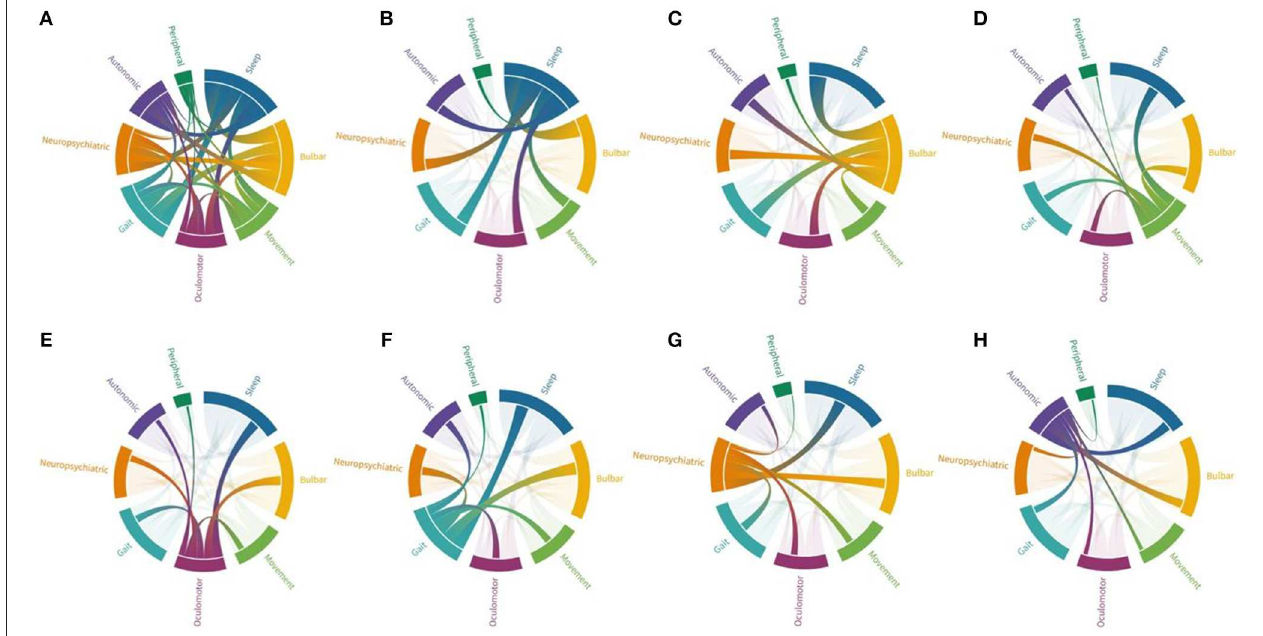
FIGURE 1 | Connections between different symptom groups in anti-IgLON5 disease. Each symptom group is represented by a fragment of the outer circular layout. Arcs represent connection and flow between groups. Fragments and arch sizes are equal to percentage of overall symptoms/flow between symptom groups. (A) Shows the combination of all symptoms. Majority of cases experienced sleep disorder and bulbar symptoms, but almost all patients have three symptoms or more. (B) When focusing on patients with sleep disorder, most cases also display bulbar symptoms followed by gait impairment, while association with peripheral symptoms is the rarest combination. (C) Patients with bulbar symptoms mainly have sleep disorder, followed by gait impairment, oculomotor abnormalities and neuropsychiatric symptoms. (D) Patients with movement disorders (mainly chorea and parkinsonism) have associative sleep disorder and bulbar symptoms, but also gait impairment. (E) Oculomotor abnormalities were associated with sleep disorder, bulbar symptoms, and gait impairment. (F) Patients with gait impairment were also found to have mainly sleep disorder, bulbar symptoms, but also neuropsychiatric symptoms. (G) Neuropsychiatric symptoms were associated with mainly sleep disorder, bulbar symptoms, and gait impairment. (H) Dysautonomia was also associated to with these